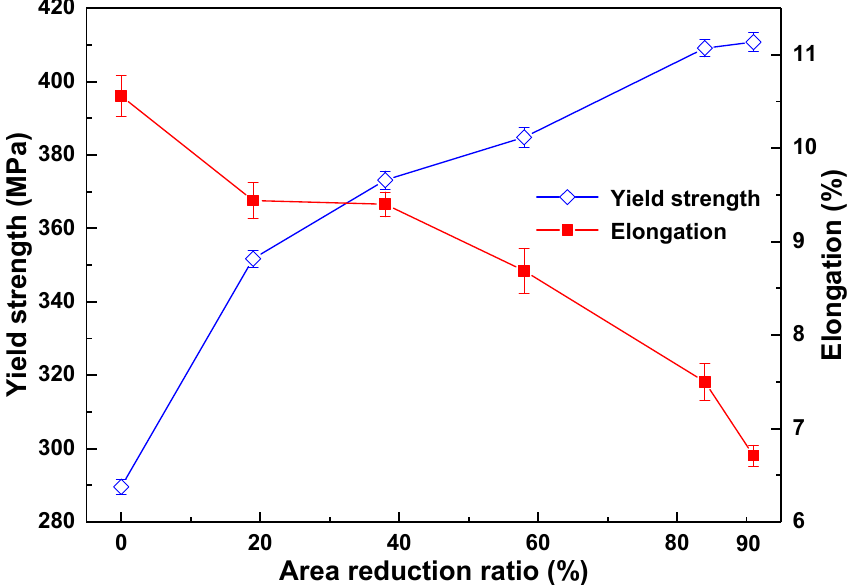
Figure 4. Variations of yield strength and elongation with different area reduction ratio of the Al-Mg-Si-Cu alloys.